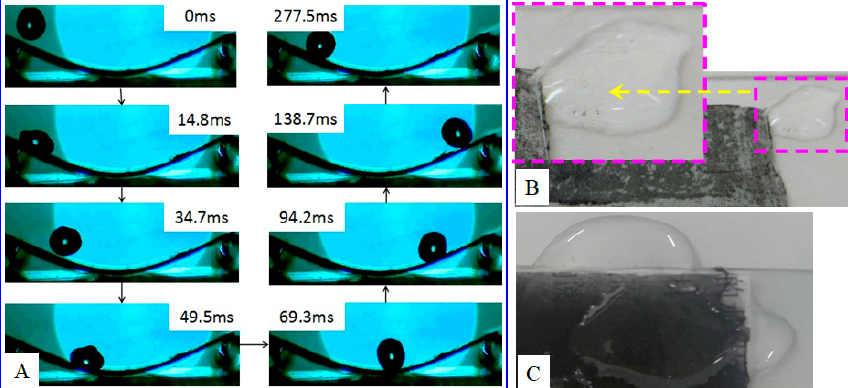
Figure 3. ( A ) The snapshots for the rolling process of a 12 µ L tap water droplet on an arc-shaped as-electrospun membrane, which is prepared on an unheated substrate; ( B ) a small number of candle soot nanoparticles taken away from the superhydrophobic membrane surface by water droplets; and ( C ) a trace of (or sometimes no visible) soot running off from the membrane, which is prepared on the heating substrate during electrospinning.